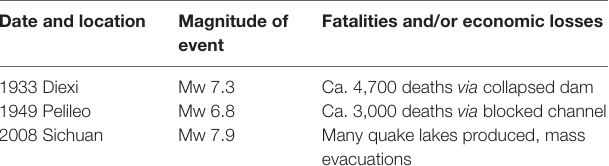
Table 6 | The effect of larger dam/blockage failures since